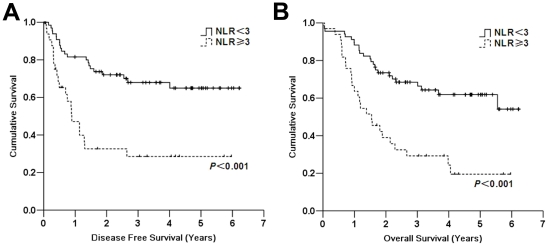
Kaplan-Meier survival curves for patients with high or normal NLR.There was a significant difference in DFS and OS between patients with low and high NLR. The 5-yr DFS (A) and OS (B) for patients with normal or high NLR were 64.9%, 28.5%, and 61.8%, 19.5%, respectively (both P<0.001).